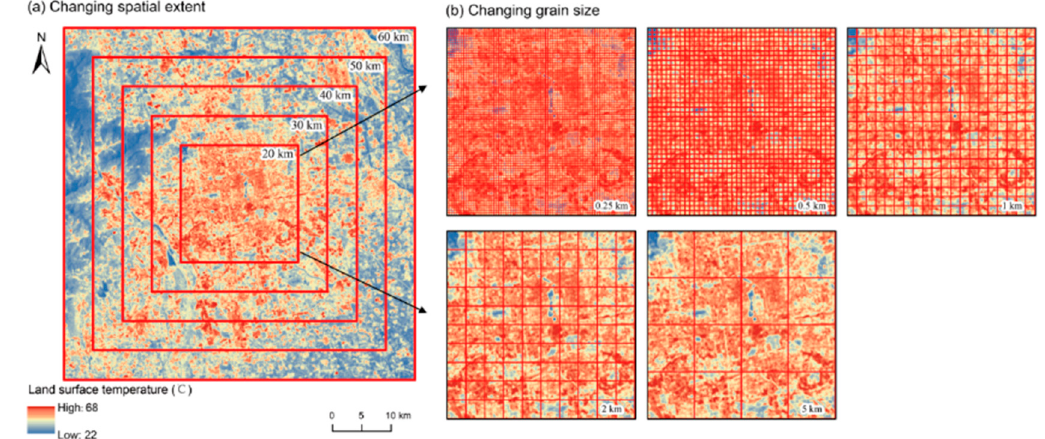
Figure A1. An illustration of scaling analysis composed by changing spatial extent (a) and changing grain size (b).